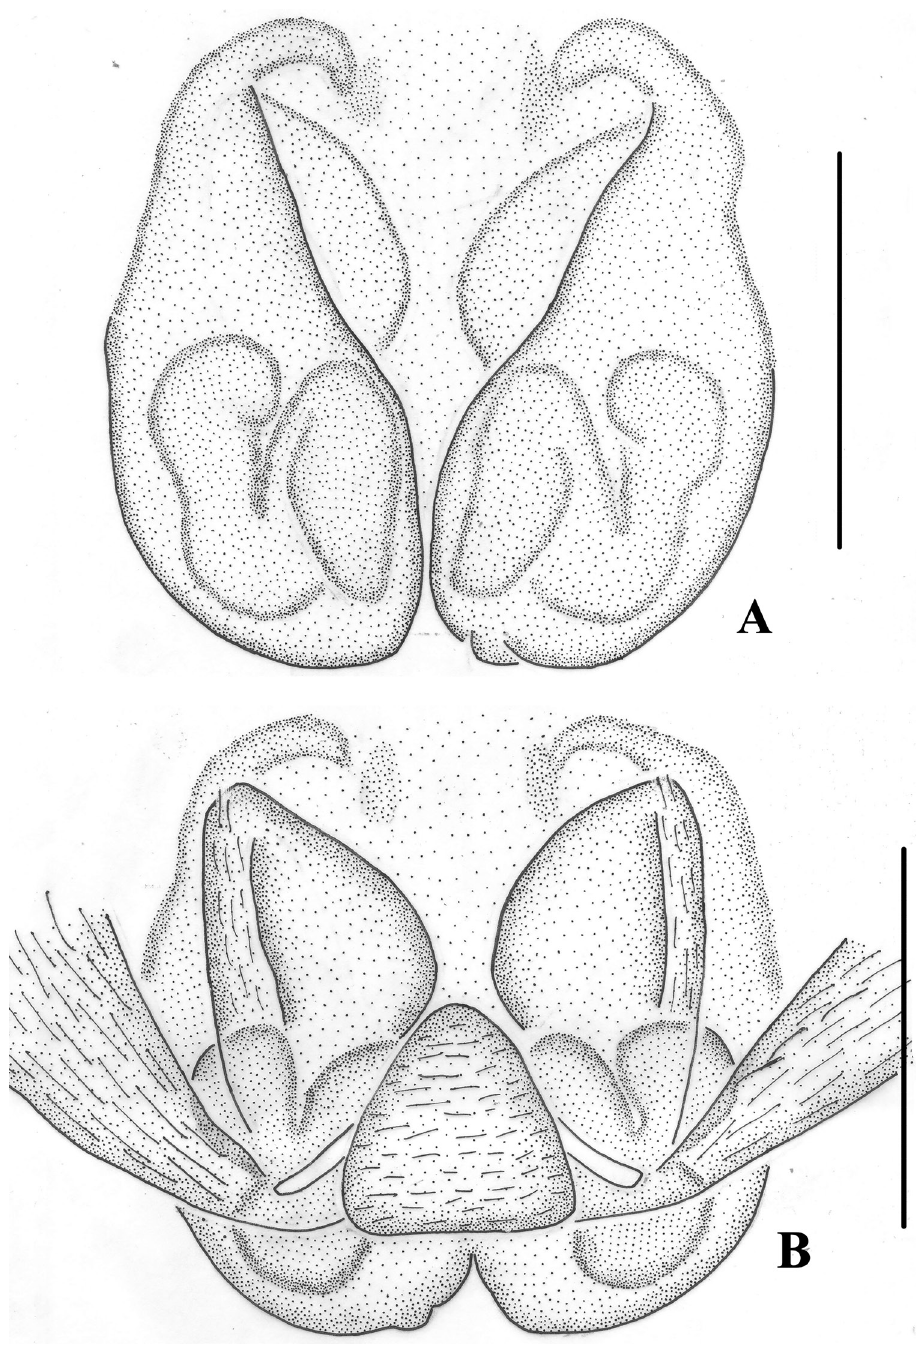
Figure 6. Pseudopoda physematosa sp. nov. A epigyne, ventral B vulva, dorsal. Scale bars: 0.5